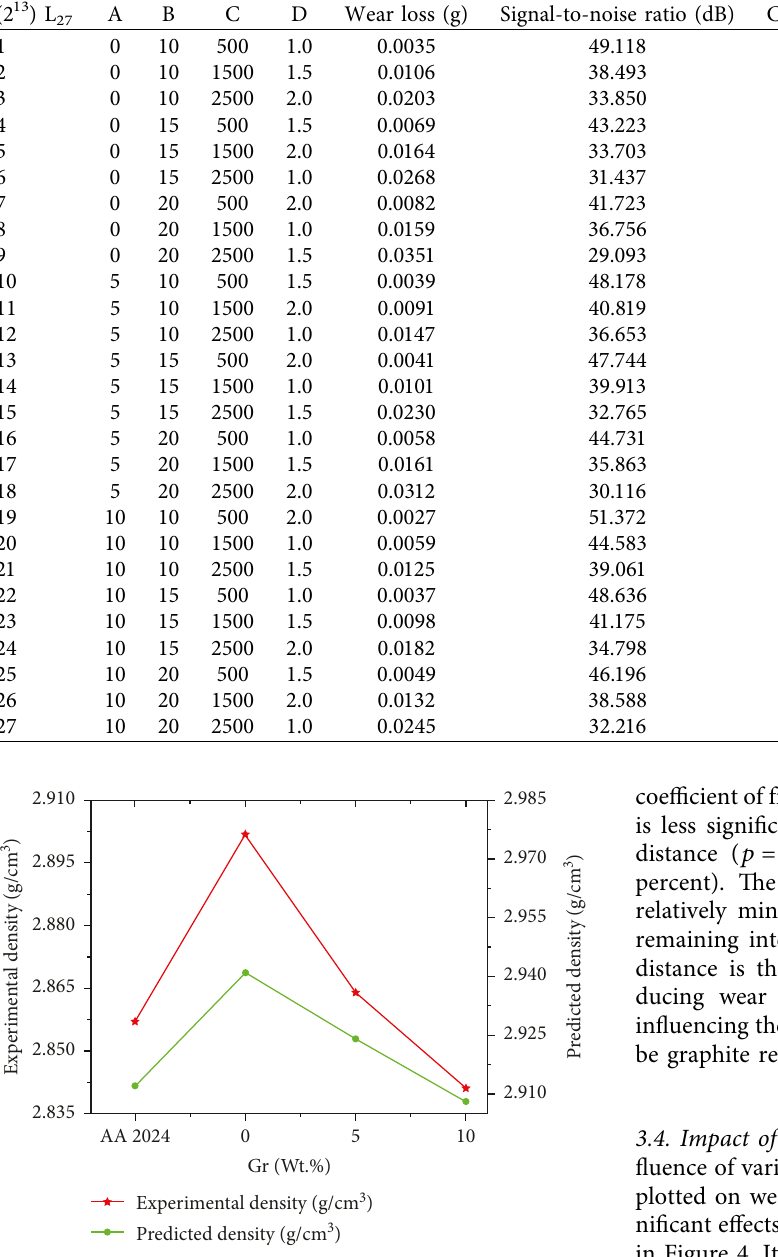
Figure 2: Experimental and predicted density of fabricated